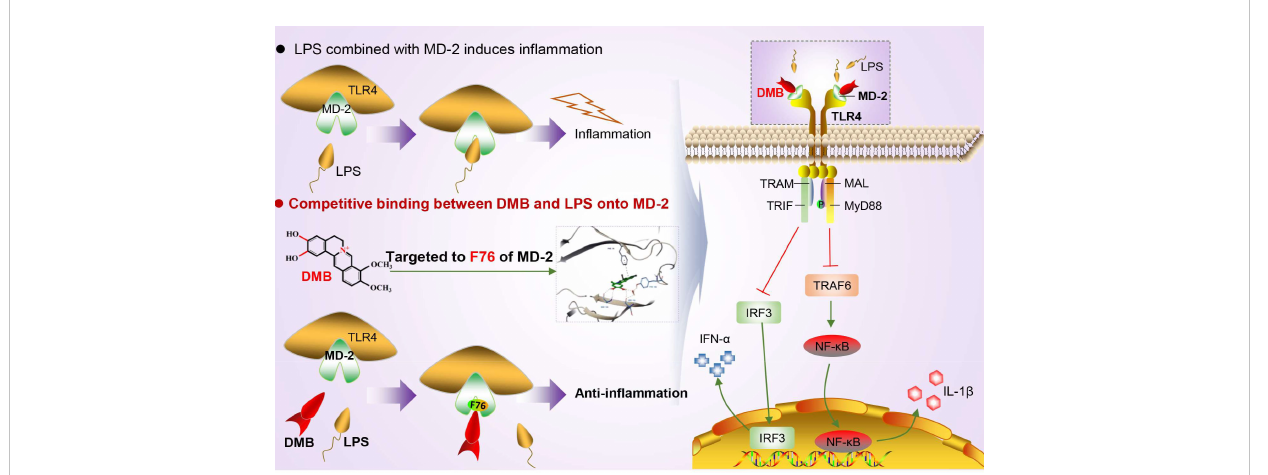
FIGURE 9 DMB targeted MD-2 to block in fl ammatory response by inhibiting the TLR4 signaling pathway. DMB signi fi cantly blocked TLR4 signaling in both an MyD88-dependent and an MyD88-independent manner via embedding into the hydrophobic pocket of the MD-2 protein with non-covalent bonding to phenylalanine at position 76 in a pi – pi T-shaped